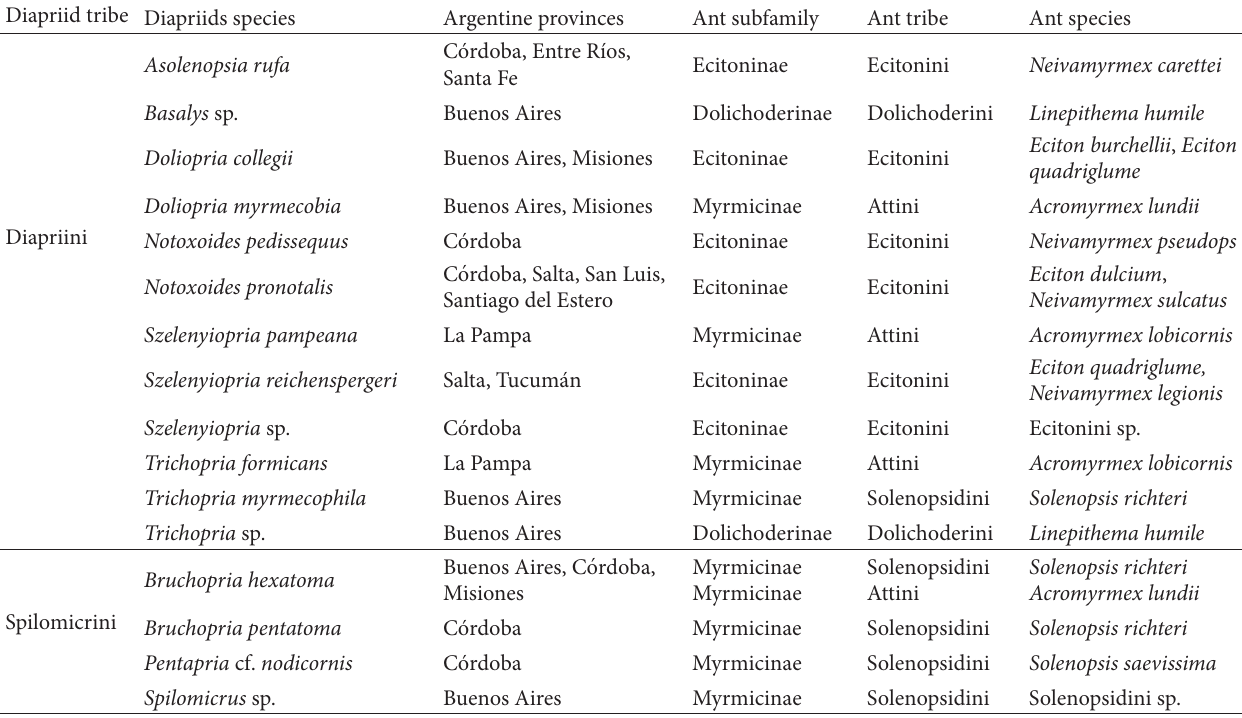
Diapriid tribe Diapriids